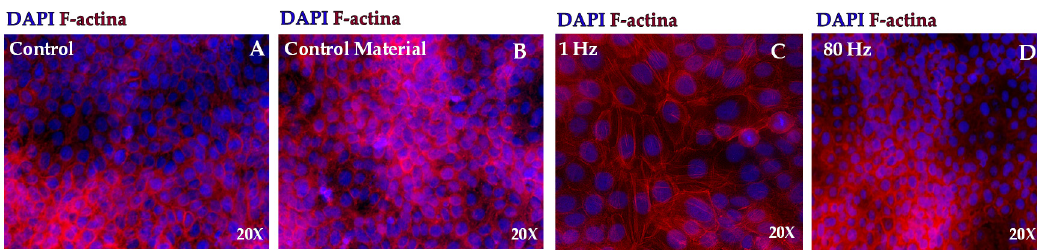
Figure 6. Immunostaining images of f-actin and DAPI at 48 h after continuous stimulation. Changes in actin distribution is observed between control samples (control ( A ) and control material ( B )) with 1 Hz stimulated samples ( C ). In the 80 Hz group ( D ), significant changes compared with control are not observed. Nucleus staining does not show significant di ff erence in size in control samples compared with 80 Hz stimulated samples. In the 1 Hz group ( C ), in some fields, the nucleus sizes were oval and elongated consistent with directions of the stress fiber.